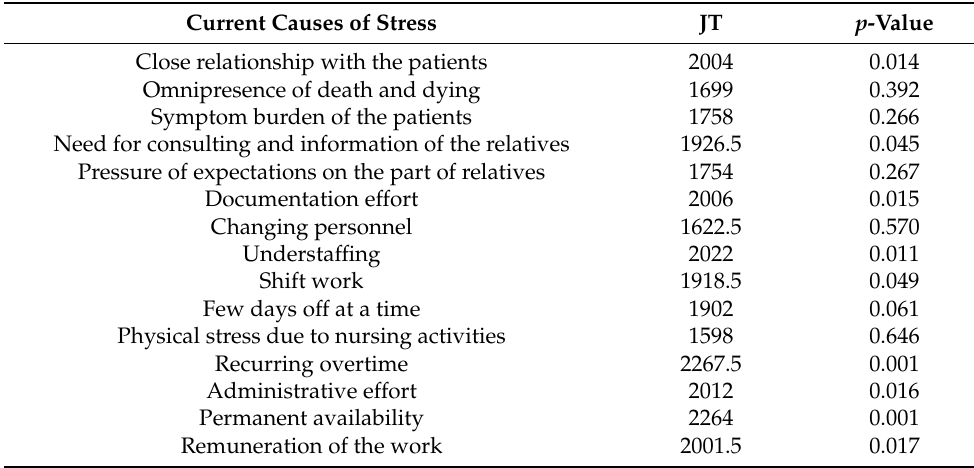
Table 6. Results derived from the explorative quantitative